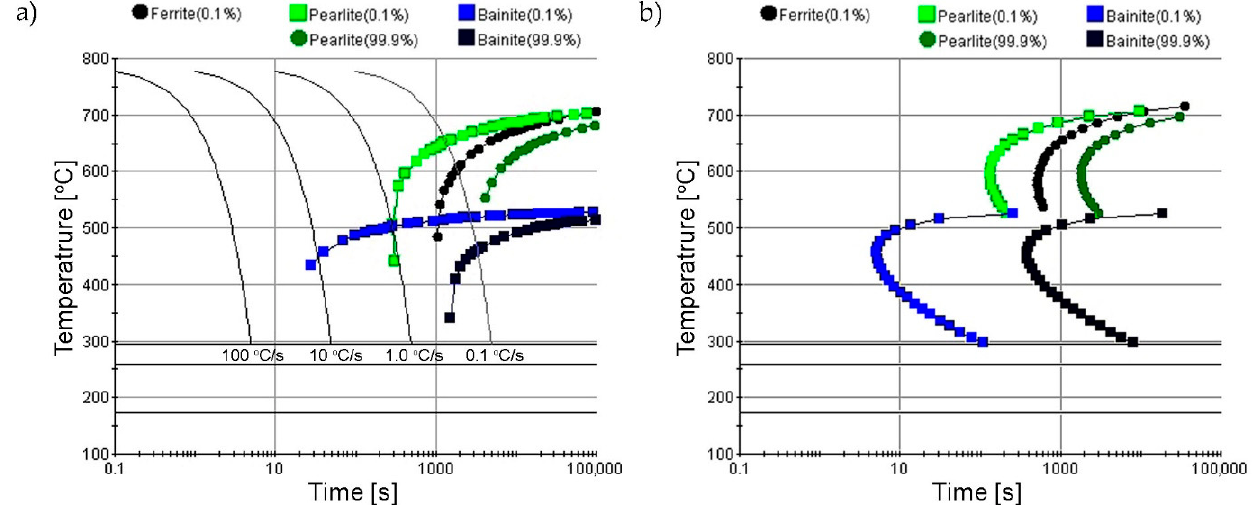
Figure 1. Time–temperature graph for steel with chemical composition (% by mass): C—0.44, Si—0.16, Mn—0.49, P—0.006, S—0.002, Al—0.04, Cr—0.83, Cu—0.02, Co—0.02, Ni—2.01, Mo—0.14, B—0.0021, Ti—0.008, V—0.008; austenitized at temperature T A = 787 °C; assumed size of the former austenite grain—10 µm. ( a ) Constant cooling—CCT. ( b ) Isothermal cooling—TTT. Assigned temperatures for individual transformations, phases and components of the structure: pearlite − 720 °C, ferrite − 736 °C, bainite − 531 °C, martensite (50%) − 258 °C, martensite (90%) − 173 °C, M S = 294 °C.